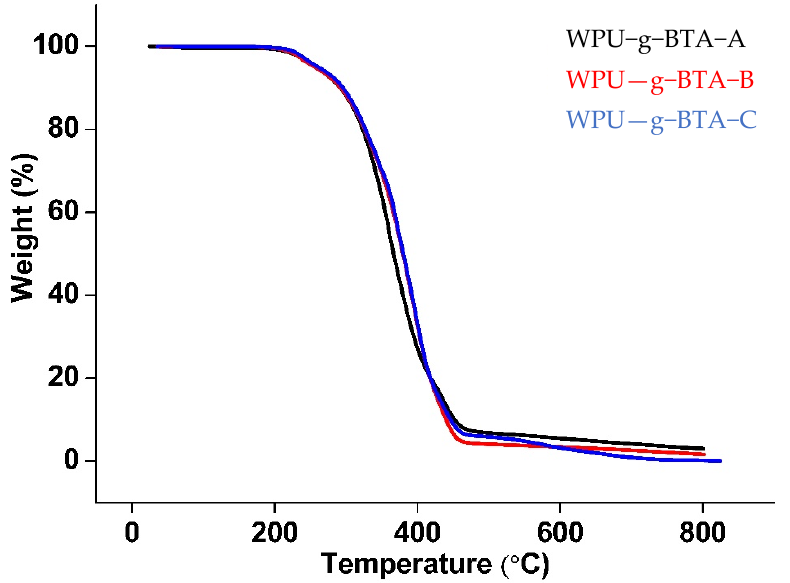
Figure 10. TGA curve of (black) WPU − g − BTA − A, (red) WPU − g − BTA − B, and (blue) WPU − g − BTA − C .